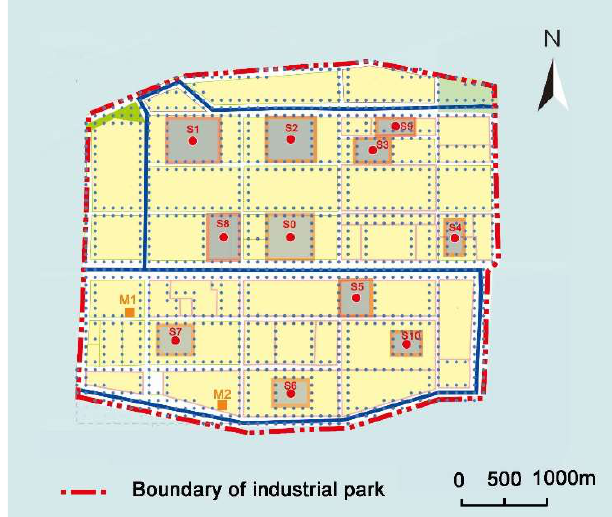
Figure 1. Distributions of sources and monitors in the industrial park. Eleven sources (S 0 –S 10 ) are denoted by red dots. The locations of existing monitors (M 1 and M 2 ) are denoted by orange squares. The arrangements of more candidate monitors are indicated by blue dots.